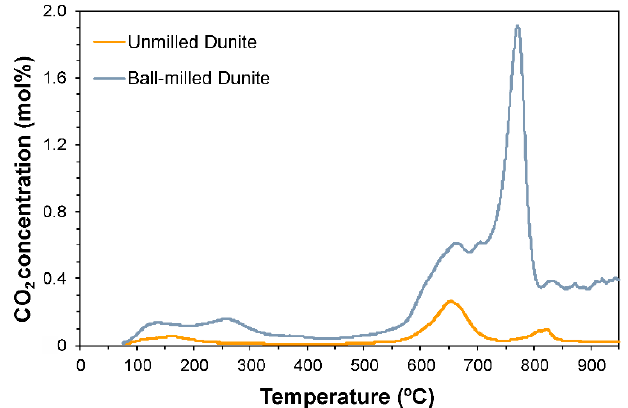
Figure 8. CO 2 temperature-programmed desorption (TPD) traces obtained under He flow for the unmilled dunite (SM15) and the ball-milled rock material with the highest CO 2 uptake (BM45). Adsorption conditions: 5 vol% CO 2 /He (50 N mL/min) at 500 ◦ C for 30 min followed by cooling of the sample to 50 ◦ C under the same gas mixture. Desorption conditions: Q He = 50 N mL/min, β = 30 ◦ C/min (data from Rigopoulos et al. [19]).